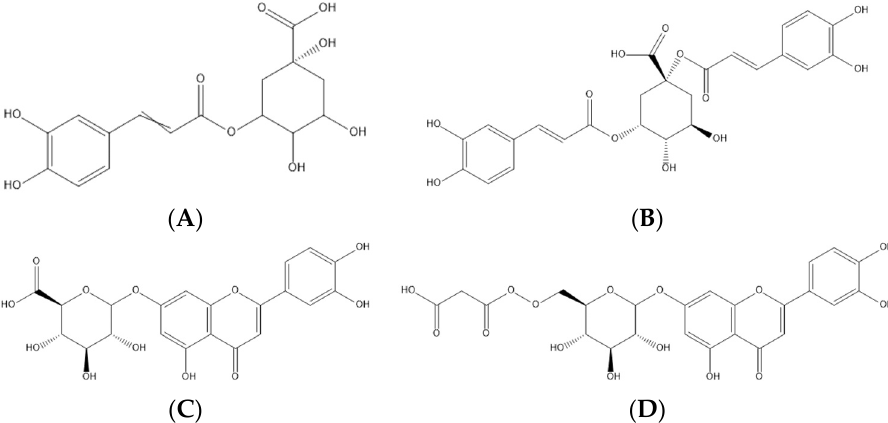
Figure 2. Representation of the four major phenolic compounds found in the cardoon samples studied—namely, two phenolic acids (5- O -caffeoylquinic-( A ) and 1,5-di- O -caffeoylquinic acids-( B )) and two flavonoids (luteolin- O -hexuronoside—( C ) and luteolin- O -malonyl-hexoside-( D )).